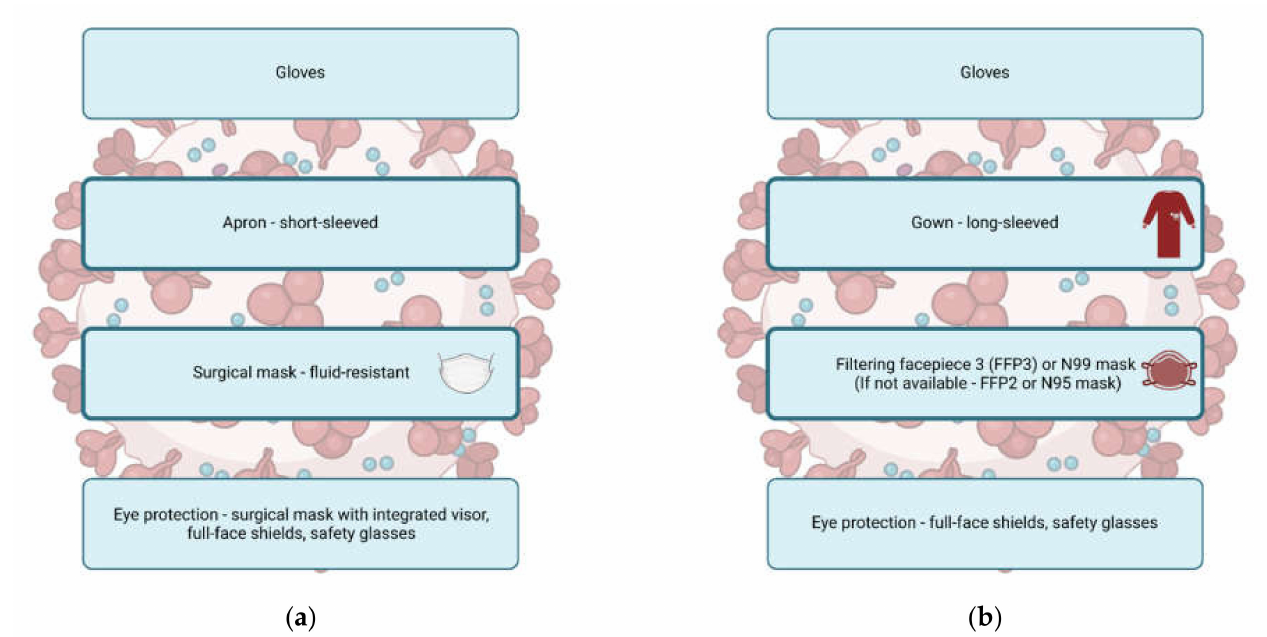
Figure 1. Minimum level of personal protective equipment (PPE) recommended by the European Resuscitation Council [32]. ( a ) Minimum level of droplet-precaution PPE. ( b ) Minimum level of airborne-precaution